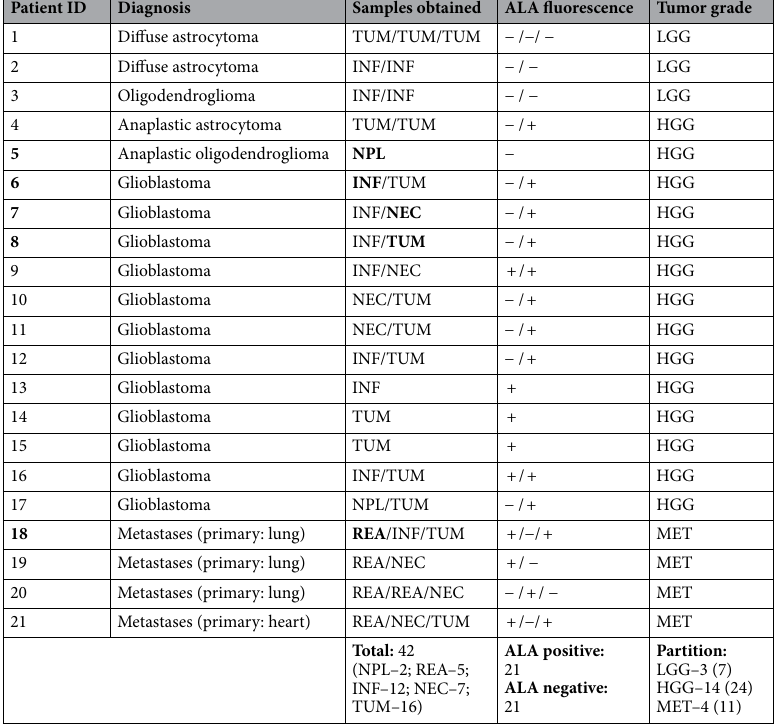
Table 1. Tissue characteristics of the 42 tumor samples obtained from 21 patients. The table shows the distribution of tissue samples obtained during fluorescence guided brain tumor resection with the patient diagnosis, the tissue histology, 5-ALA fluorescence status during surgery (visible to surgeon: +/ not visible to surgeon: −) as well as the confirmed tumor grade (LGG: low grade glioma, HGG: high grade glioma, MET: brain metastases). Bold entries specify the representative tissue samples which are shown in Fig.